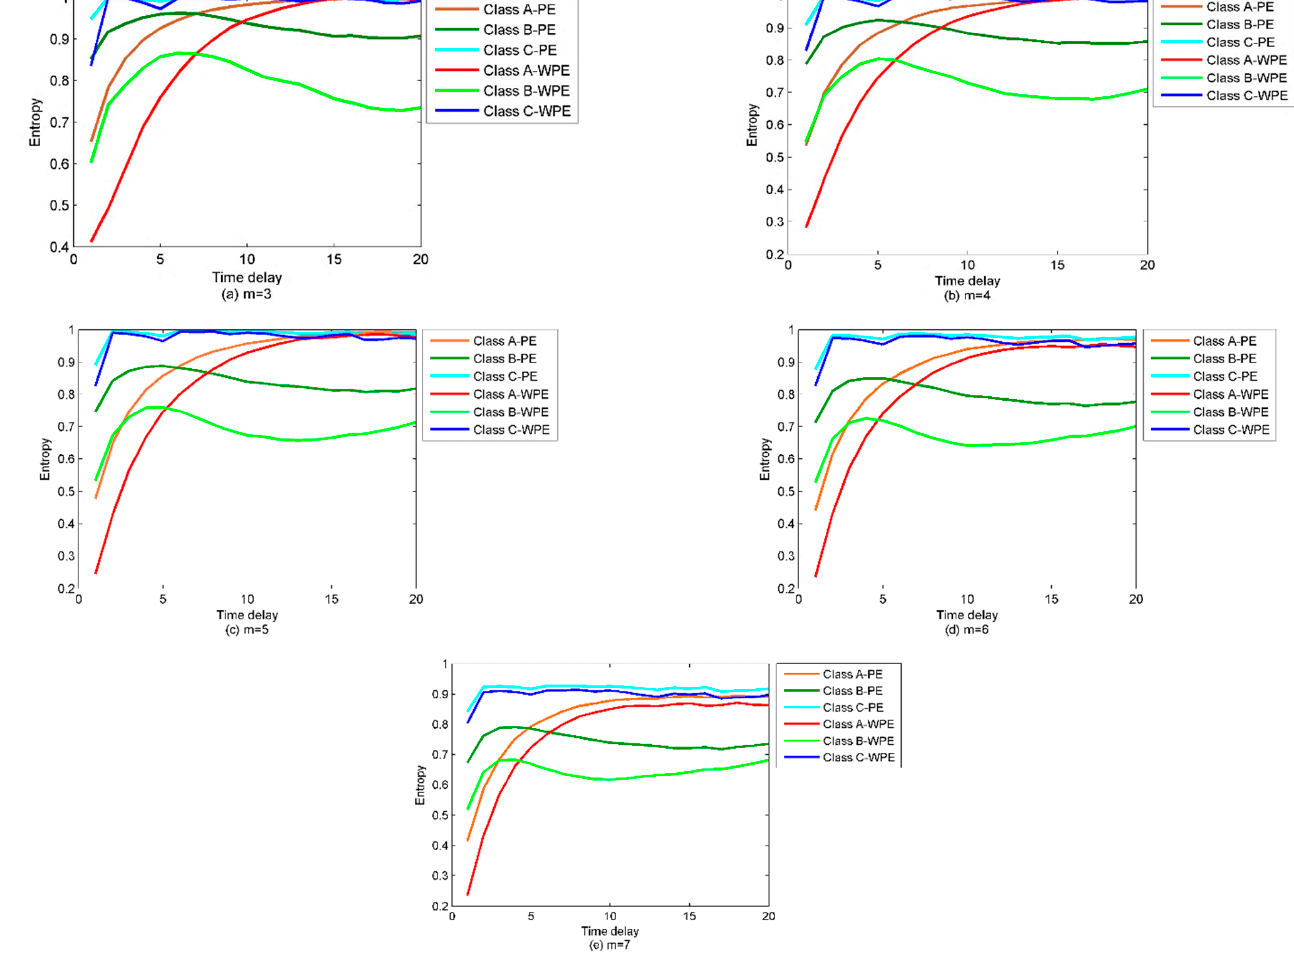
Figure 10. PE, WPE comparison of the three types of SRN under different embedding dimensions.